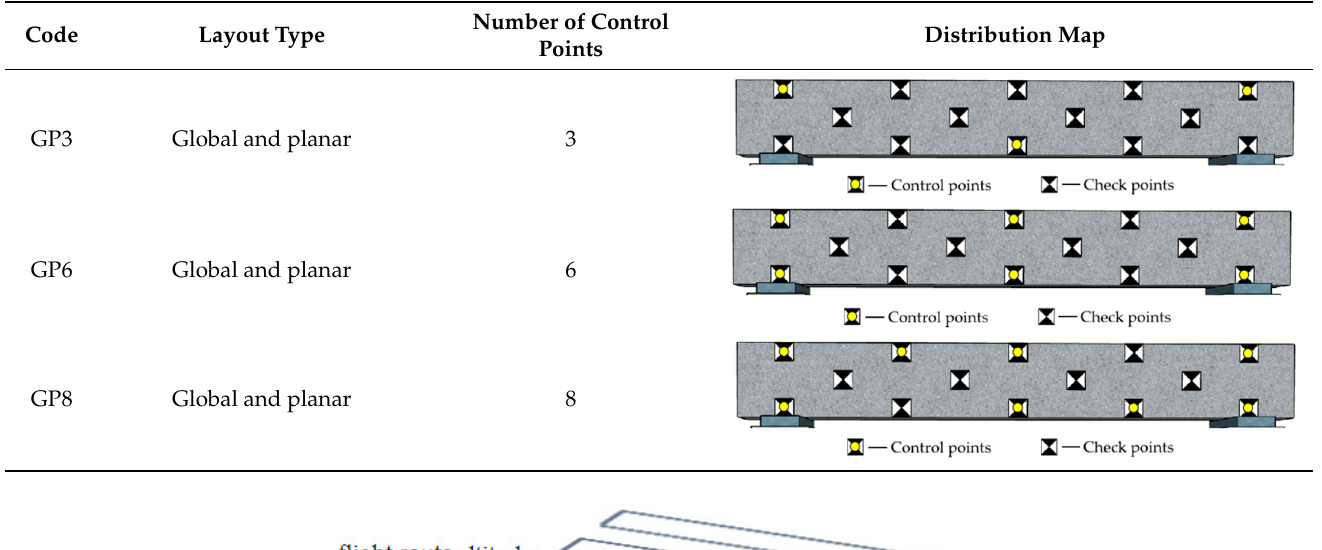
Table 2. Arrangement of reference points on the concrete beam.